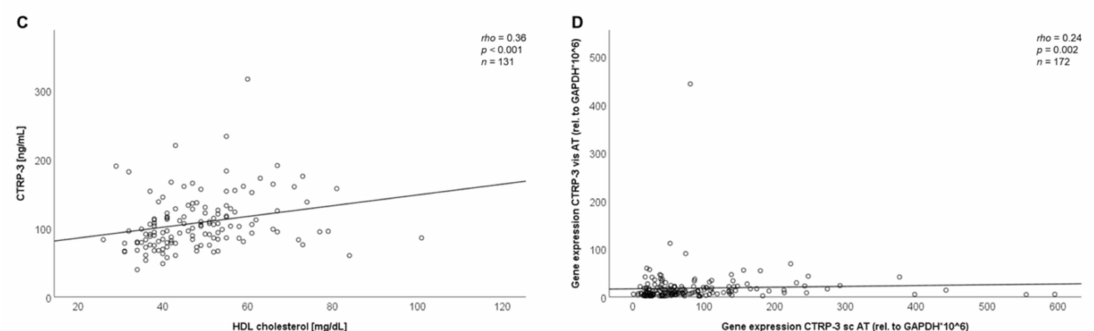
Figure 2. Correlation of baseline CTRP-3 serum levels with anthropometric and biochemical parameters. Adiponectin and CTRP-3 serum concentrations were measured by ELISA. Gene expression levels in adipose tissues were analyzed via RT-PCR. AT, adipose tissue; BS, bariatric surgery; GAPDH, glyceraldehyde-3-phosphate dehydrogenase; LCD, low calorie formula diet; sc, subcutaneous; vis, visceral. ( A ) Positive correlation of CTRP-3 and adiponectin serum concentrations within the BS cohort. ( B ) Positive correlation of CTRP-3 and adiponectin serum concentrations within the LCD cohort. ( C ) Positive correlation of serum CTRP-3 and HDL levels within the LCD cohort. ( D ) Positive correlation of CTRP-3 gene expression in subcutaneous and visceral adipose tissue of bariatric patients.